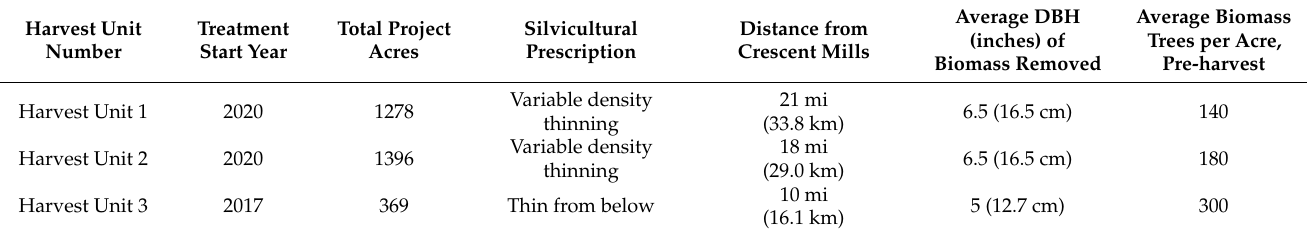
Table 1. Harvest unit details for three projects in the Plumas National Forest used for this